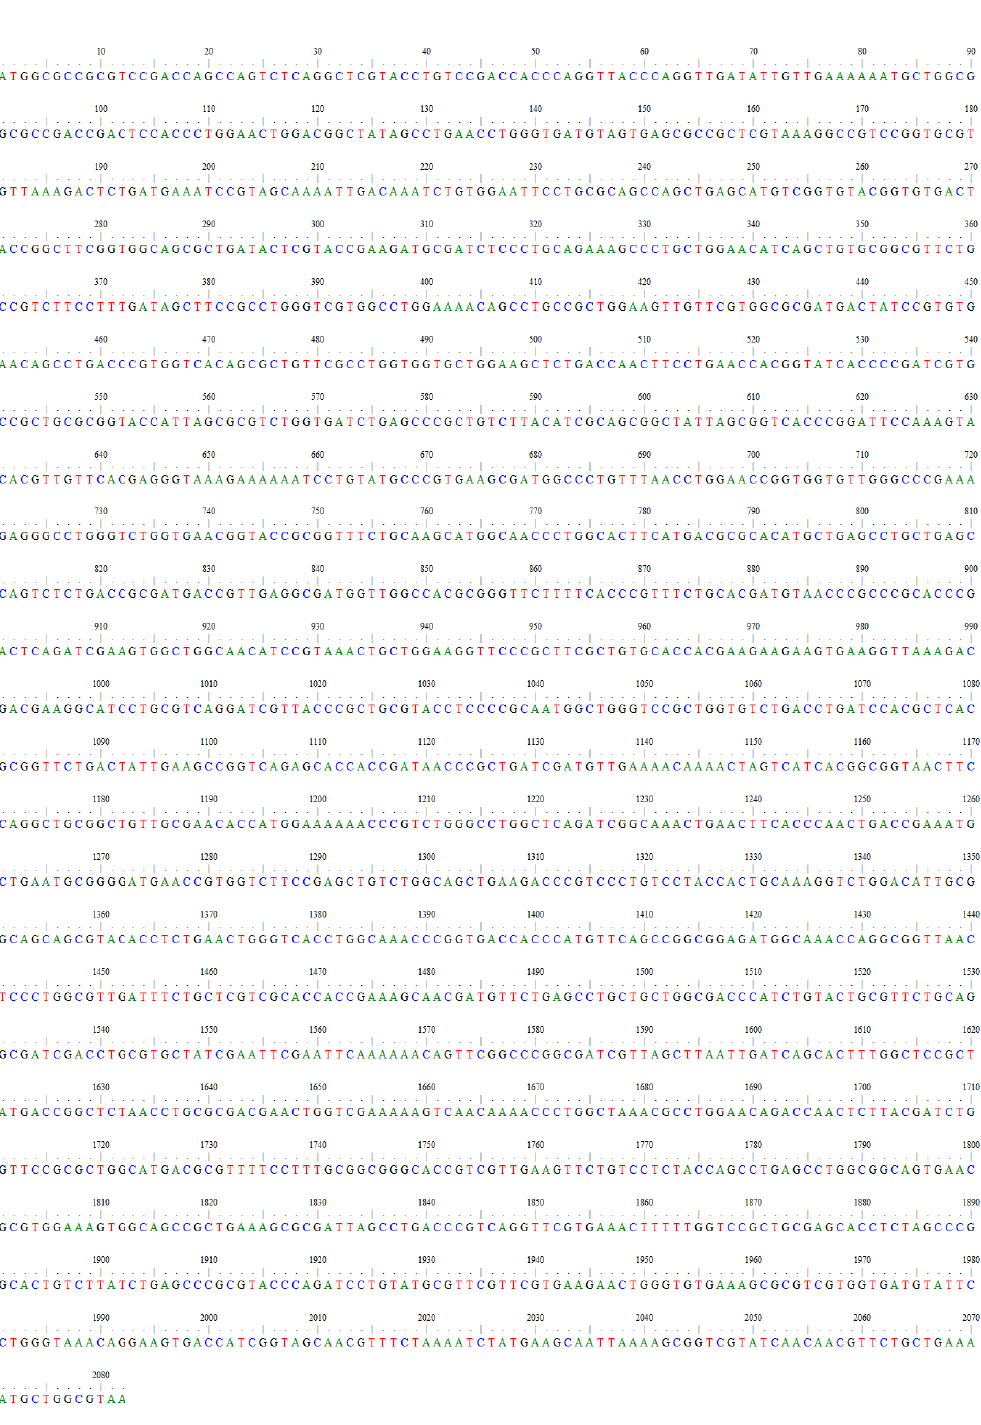
Figure A4. The codon-optimized DNA sequence of the yeast Rhodotorula glutinis PAL/TAL.